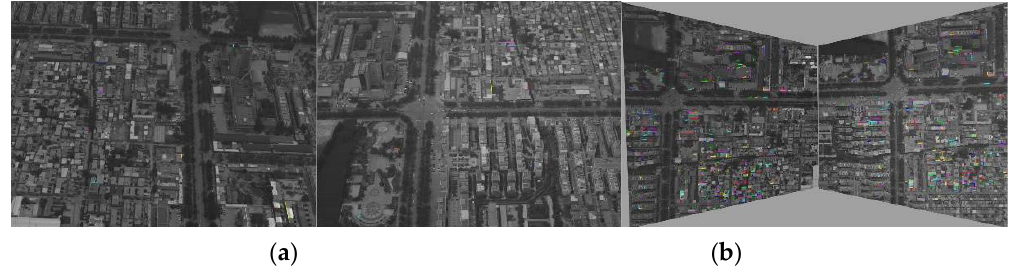
Figure 13. Comparison of the line matching results of the fourth image pair between original images and rectified images: ( a ) original images, 2/15/15%; ( b ) rectified images, 332/374/88.8%. Finally, line segments matched on rectified images are back-projected to the original images, as